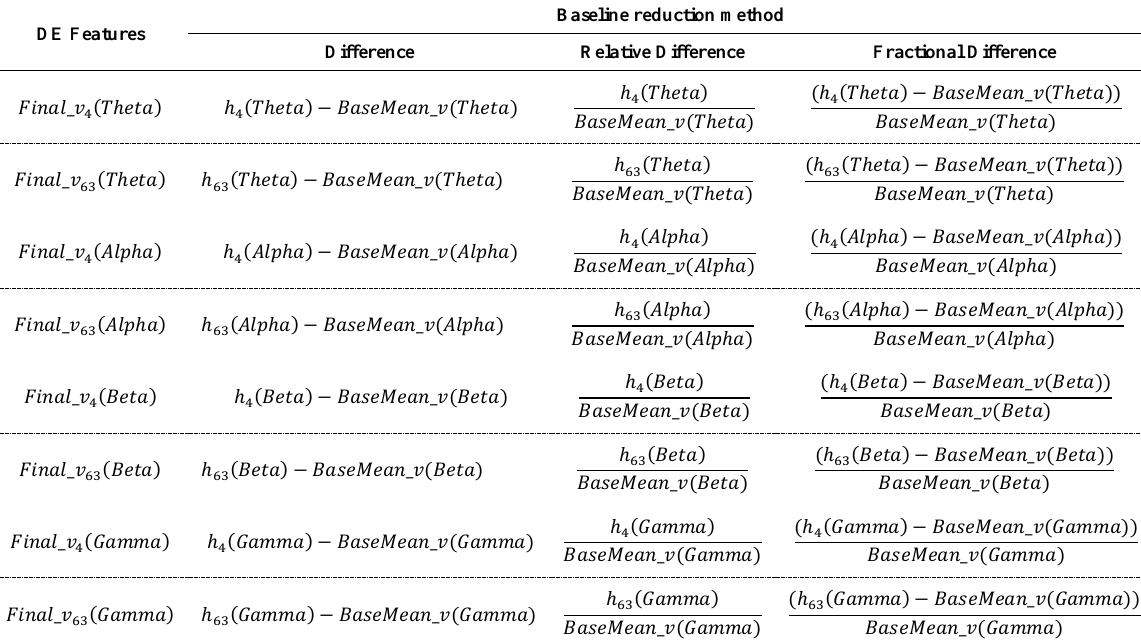
Table 7. Illustration of the baseline reduction using Difference, Relative Difference, and Fractional Difference methods on the DEAP